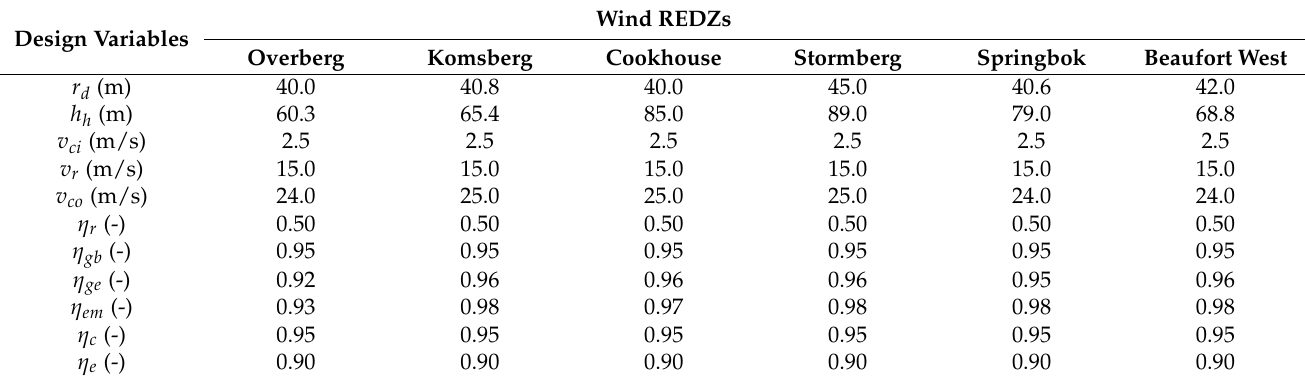
Table 12. Actual optimal design variables from NSGA-II.